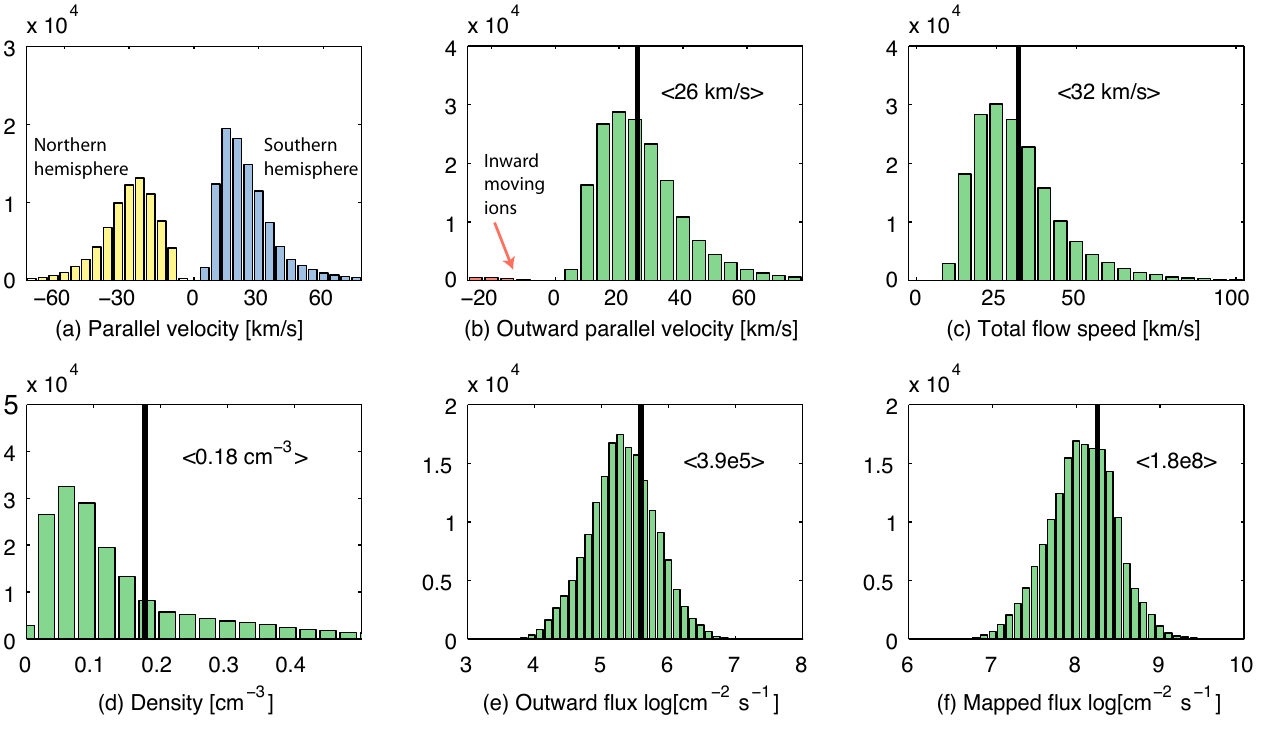
Fig. 8. Properties of the high-latitude ion outflow. (a) Velocity along the magnetic field. (b) The magnetic field aligned velocity away from the Earth. Negative outward parallel velocities correspond to inward moving ions, which are only seen in a few events. (c) Total speed of the ions. (d) Density derived from the spacecraft potential measured by EFW. (e) Outward proton flux obtained from the outward parallel velocity times the density corrected by a factor of 0.8 (see Sect. 2.2). (f) The corresponding ionospheric flux has been calculated mapping each flux value back to the ionosphere at 1000km, where the magnetic field is assumed to be 37 µ T. (The total data set consists of 180000 points.)